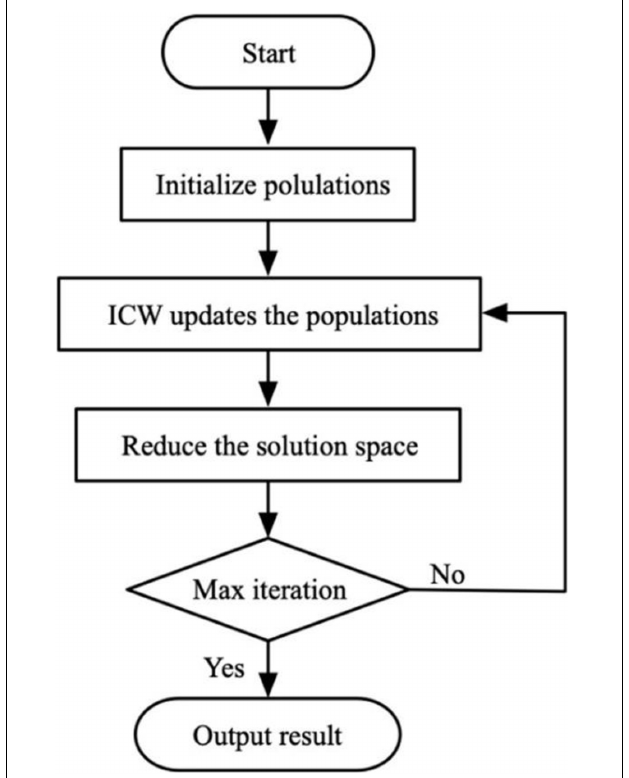
FIGURE 3 | Flow chart of